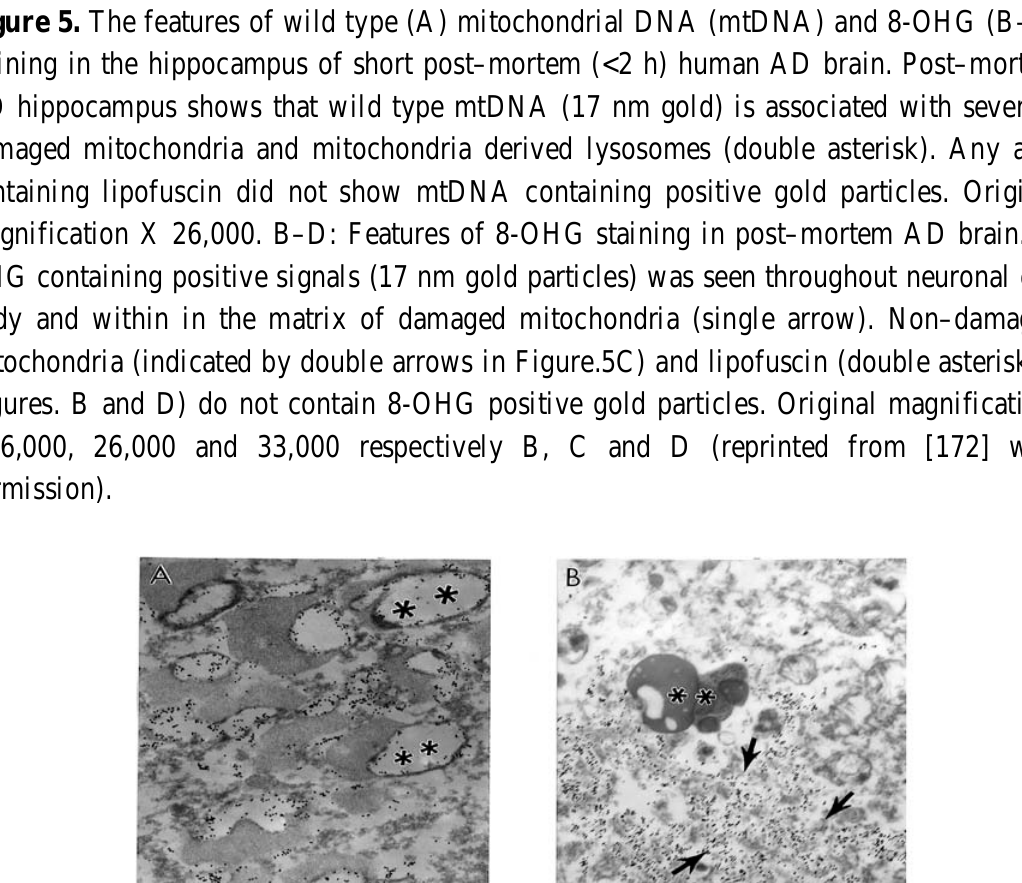
Figure 5. The features of wild type (A) mitochondrial DNA (mtDNA) and 8-OHG (B–D) staining in the hippocampus of short post–mortem (<2 h) human AD brain. Post–mortem AD hippocampus shows that wild type mtDNA (17 nm gold) is associated with severely damaged mitochondria and mitochondria derived lysosomes (double asterisk). Any area containing lipofuscin did not show mtDNA containing positive gold particles.